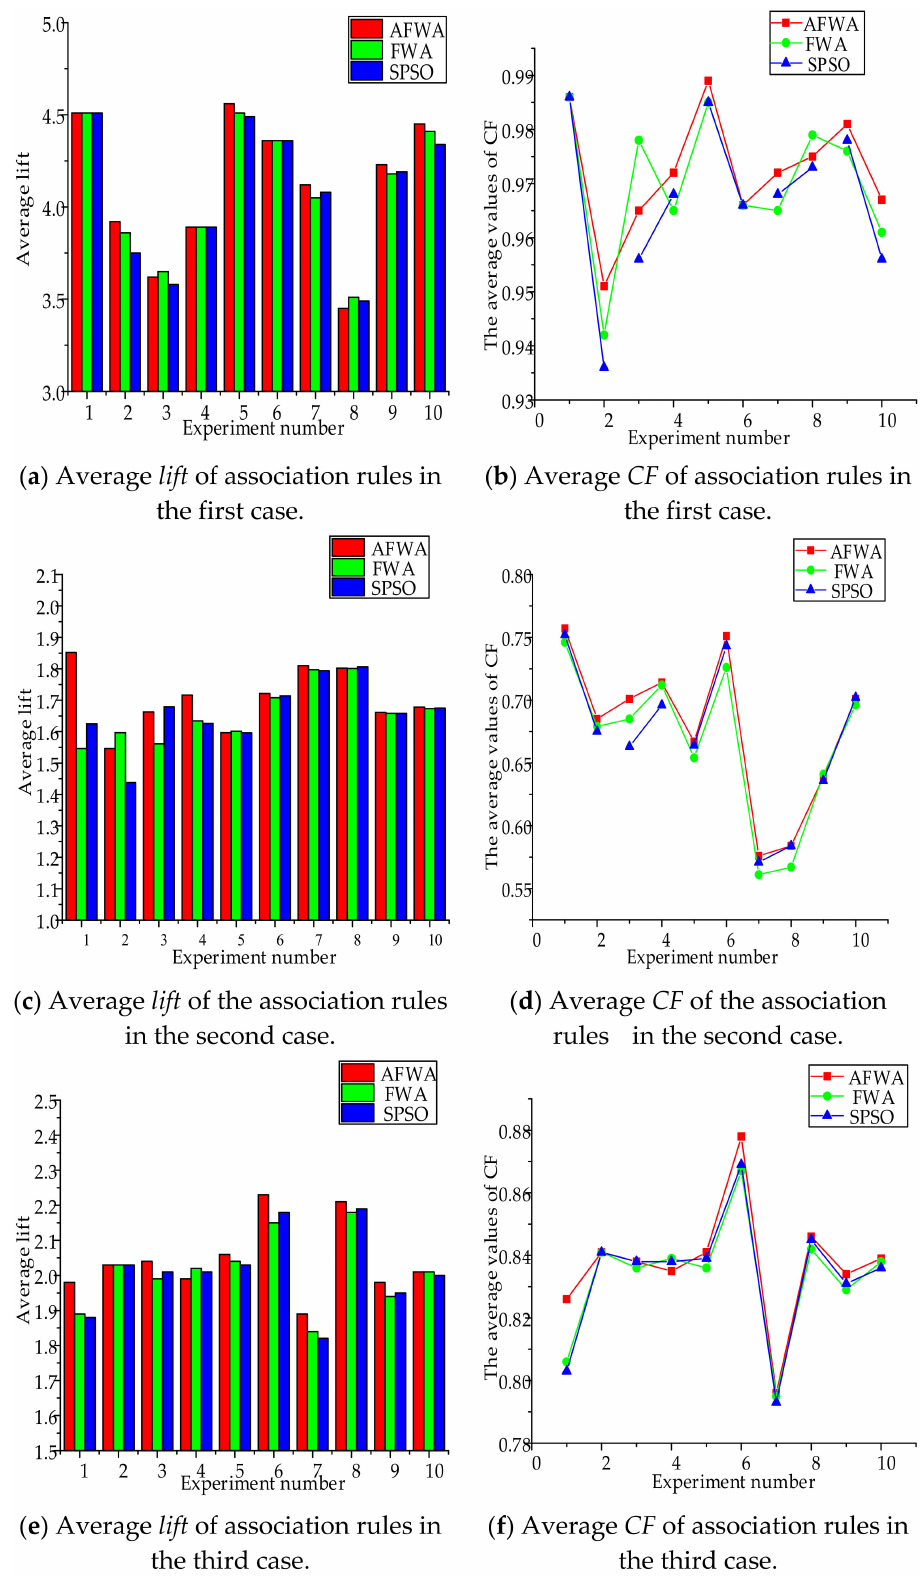
Figure 9. Comparison diagram of the algorithm